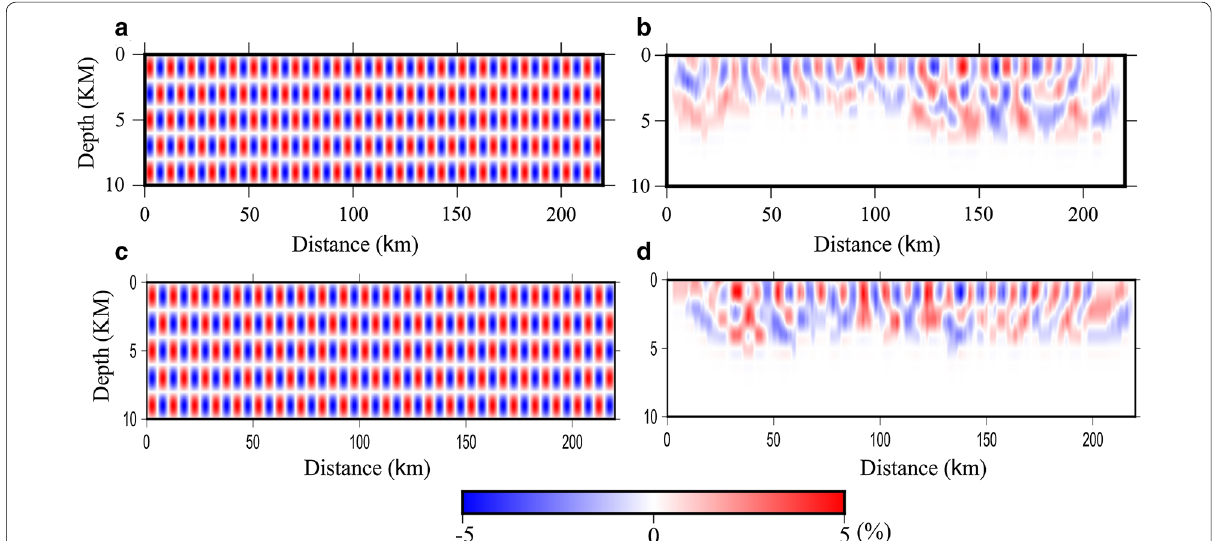
Fig. 10 Results of checkerboard resolution tests for the upper crust of P-wave velocity model. a , b Respectively the 5 recovered result for the P-wave velocity model. c , d Respectively the 5